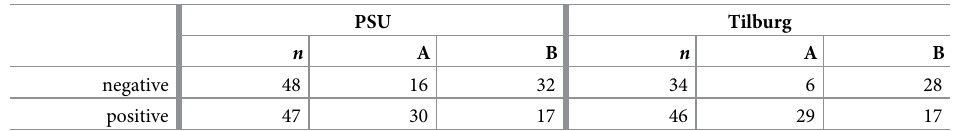
Table 4. Data for the second example.